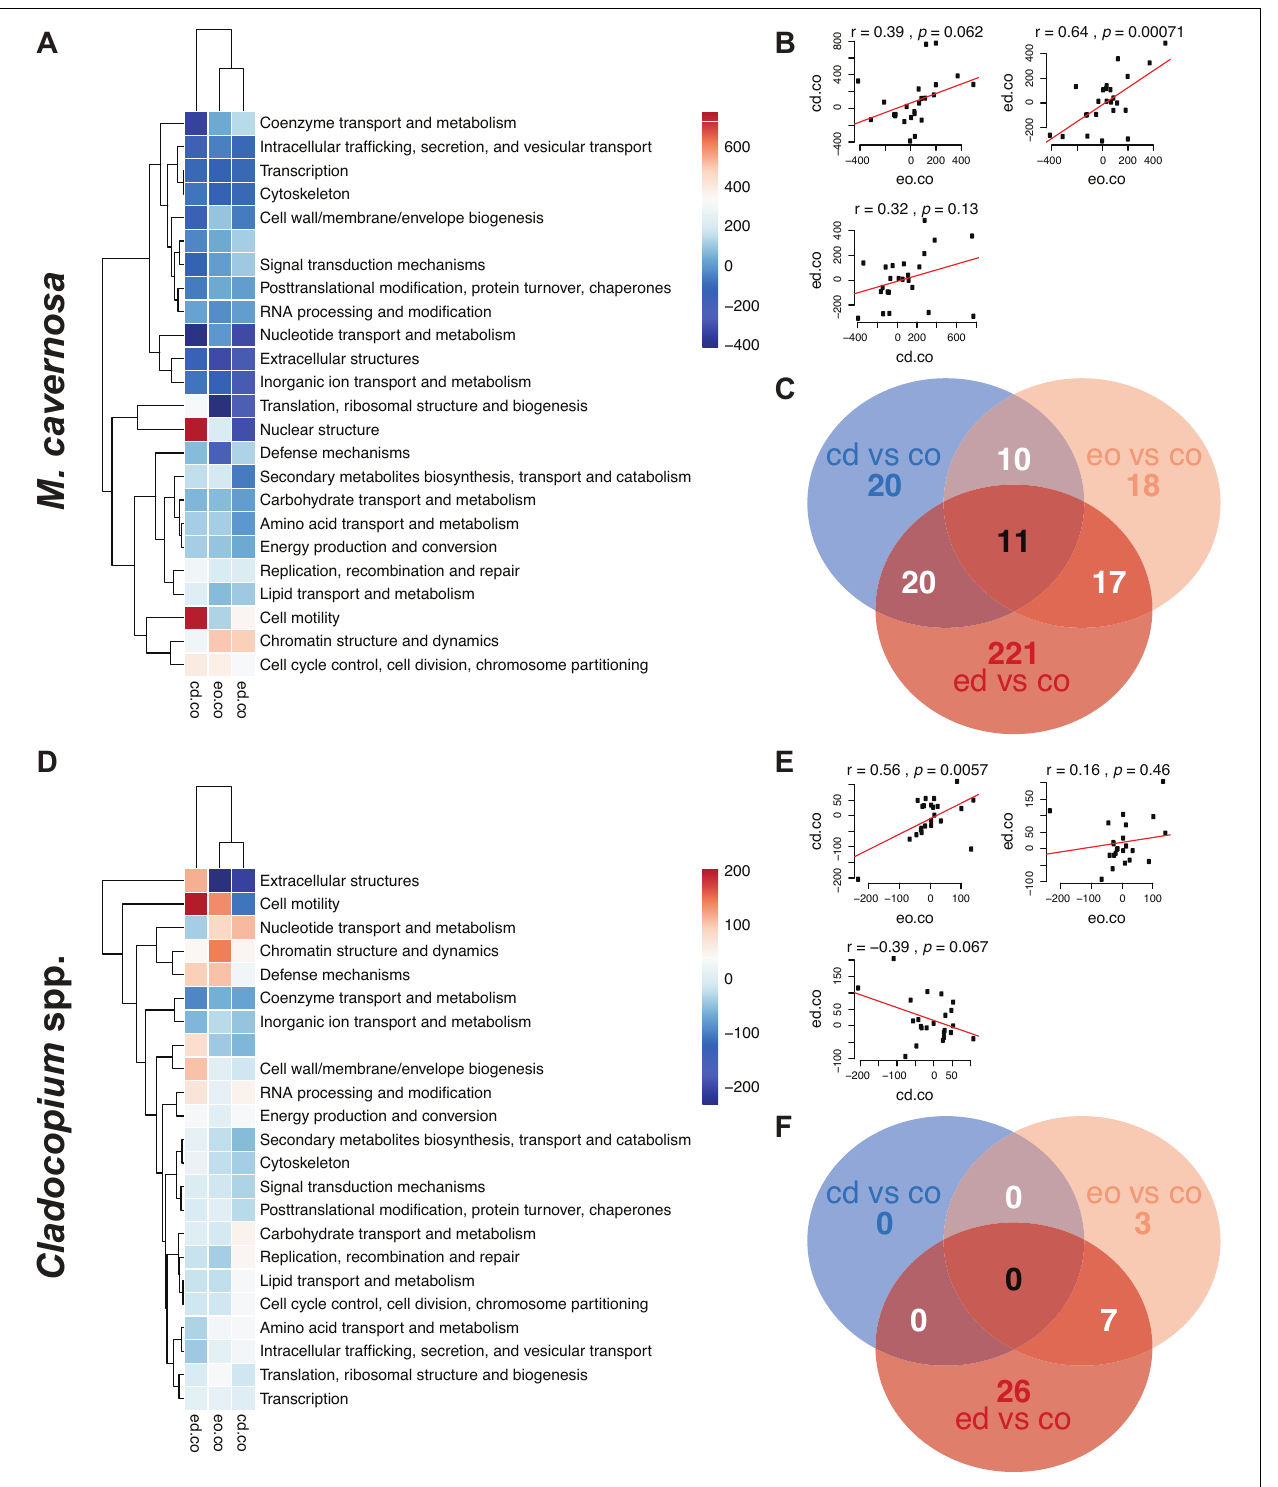
FIGURE 3 | (A,D) Heatmaps of eukaryotic orthologous groups (KOGs) among pairwise comparisons of water + temperature factors for the ex situ experiment, split into coral host ( M. cavernosa ) and symbiont ( Cladocopium spp.) datasets. Increasing intensities of red/blue indicate enrichment of KOGs more-expressed/less-expressed in treatments (cd, control discharge; eo, elevated offshore; ed, elevated discharge) versus control offshore (co) samples. Color values represent ranks generated from Mann–Whitney U tests. Hierarchical networks on both axes display the similarities among pairwise comparisons ( x -axis) and KOG classes ( y -axis). (B,E) Panels of correlation analyses between pairwise comparison combinations. (C,F) Venn diagram displaying the number of DEGs associated with each pairwise treatment comparison.